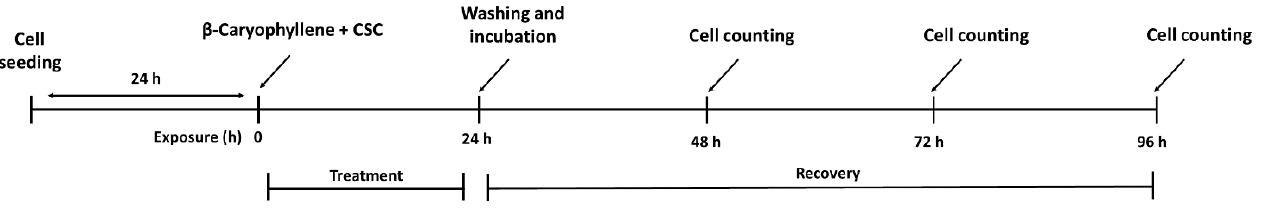
Figure 3. Scheme of the treatment protocol applied to evaluate the recovery abilities of triple-negative breast cancer MDA-MB-468 cells after a 24 h exposure to β -caryophyllene and cigarette smoke condensate (CSC) alone and in co-treatment.